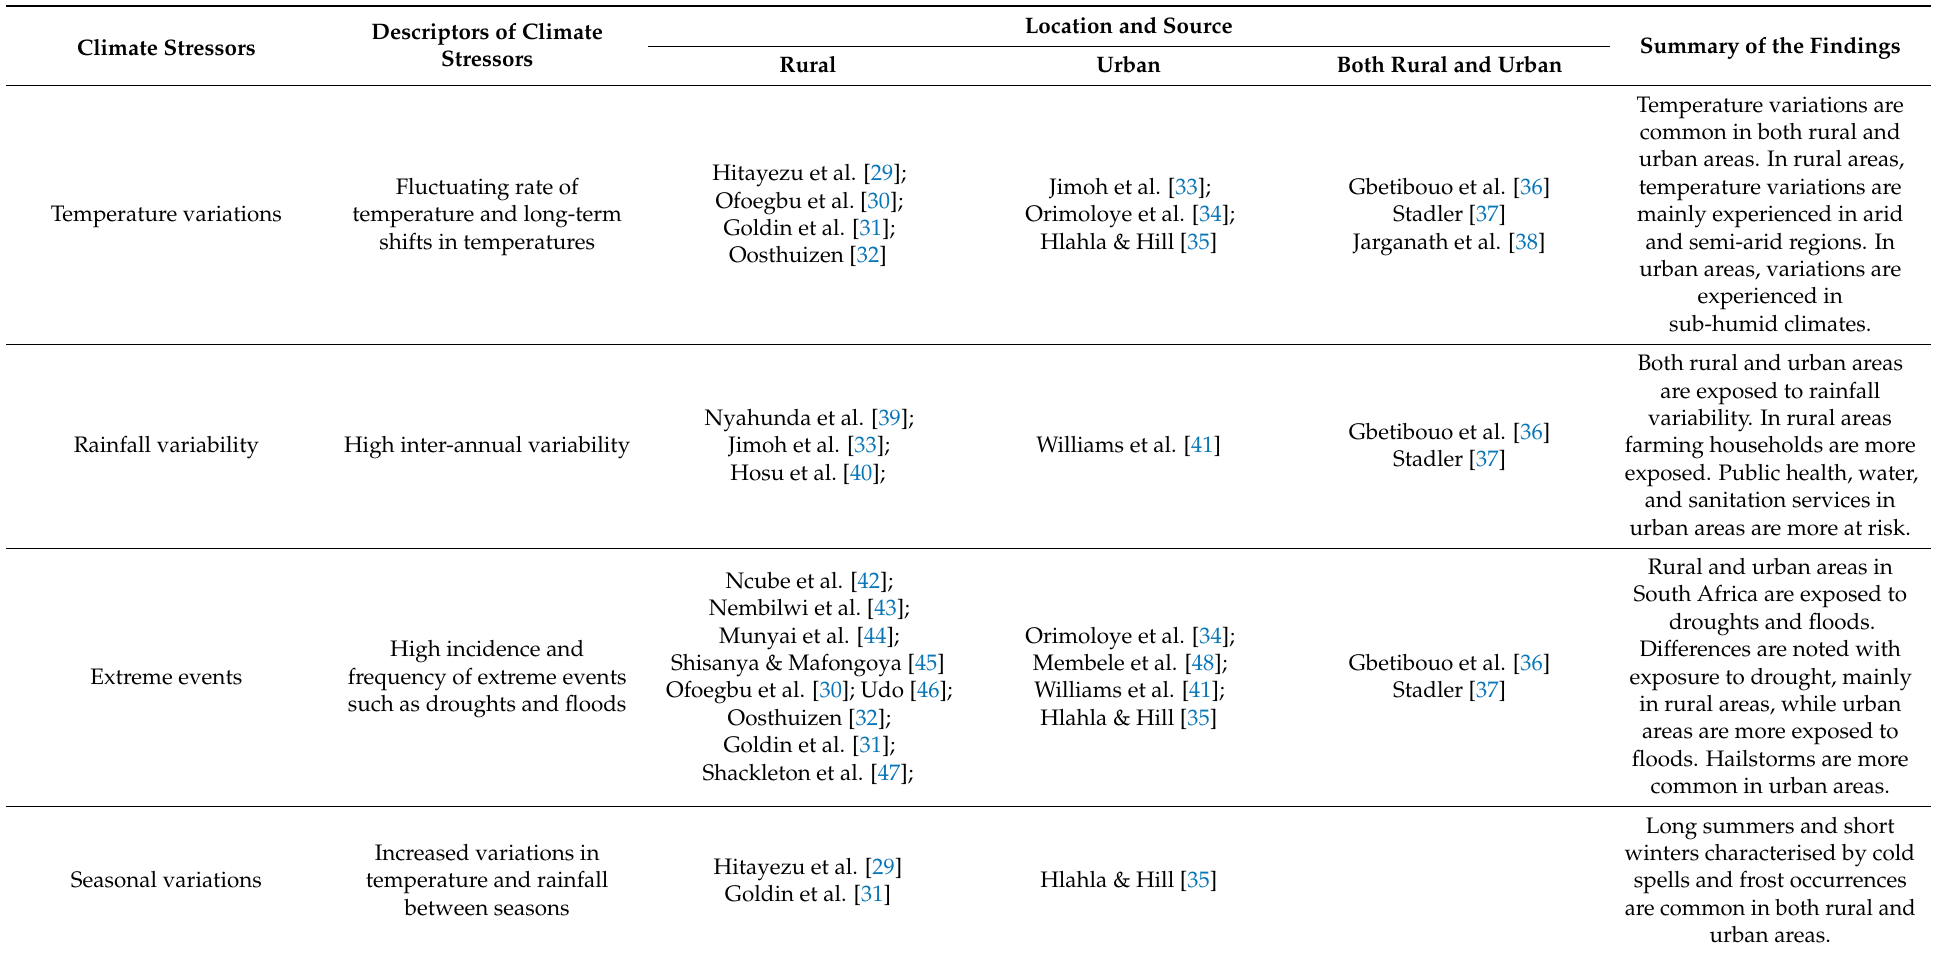
Table 2. Climate change stressors exacerbating exposure of urban and rural areas in South